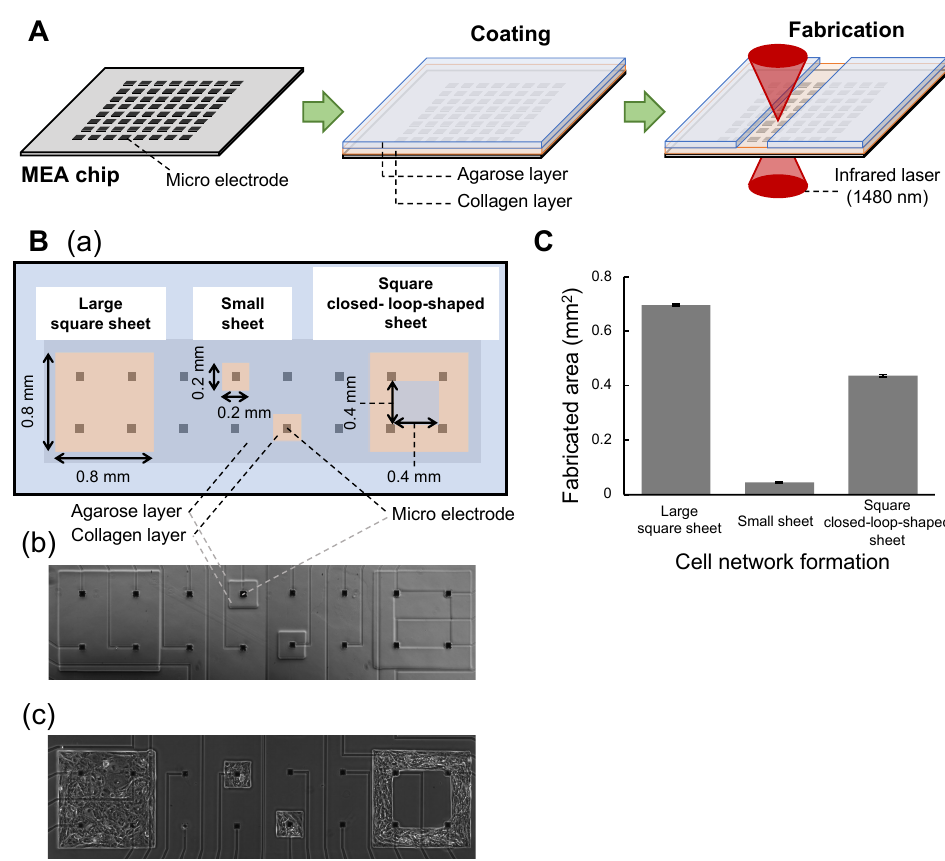
Figure 1. Fabrication of three types of cardiomyocyte networks on a multielectrode